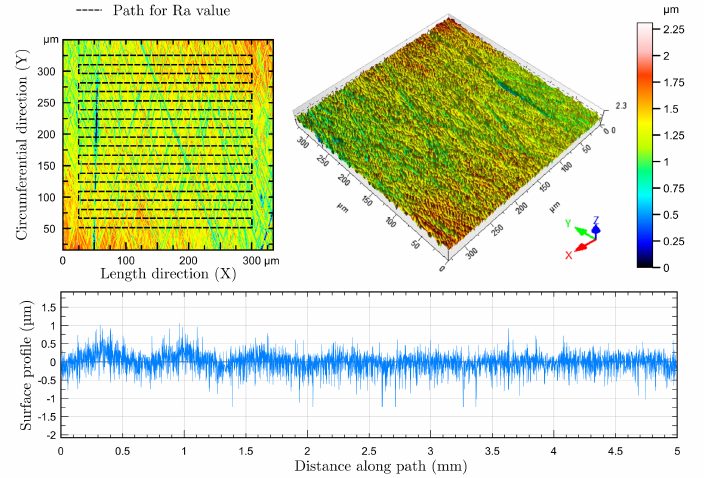
Figure 4. Surface profile measurement example of one of the tested fatigue specimens. Measurement performed with a white light